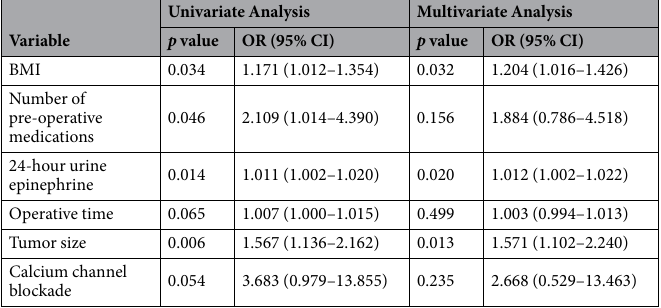
Table 5. Uni- and multivariate analyses for predictors of post-operative SH/LA. BMI, body mass index; OR, odds ratio; CI, confidence